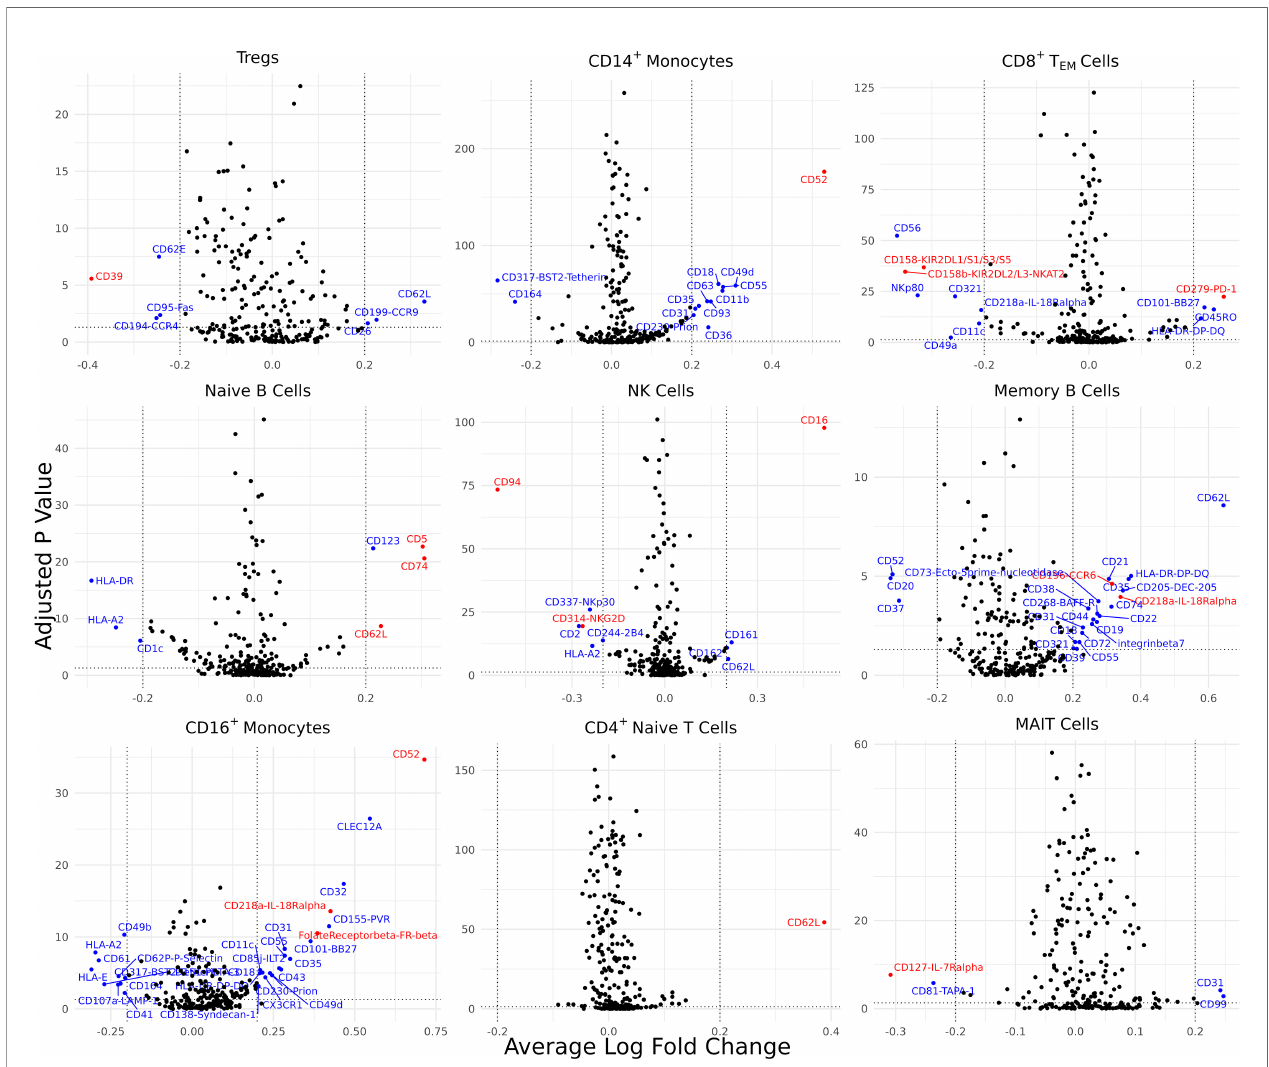
FIGURE 3 | Cell type-speci fi c DE proteins between AS and healthy subjects. Volcano plots showing the DEPs for 9 cell types based on cells with measured ADT data; blue points represent statistically signi fi cant proteins and proteins mentioned in the paper are highlighted in red. DEPs were identi fi ed based on a Bonferroni- adjusted p-value < 0.05 and absolute average difference ≥